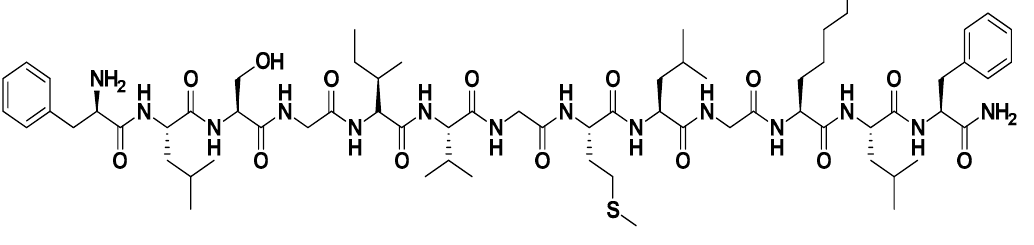
Figure 1. Structure of temporin-SHa. Table 1. Sequence of peptides used in this study. Temporin-SHa (SHa) is the original peptide. Substitution of one Gly or more is shown in red for D -Ala and in blue for L -Ala. NS = no substitution (natural peptide). G4 = Gly at position 4. G7 = Gly at position 7. G10 = Gly at position 10. a = D -Ala. A = L-Ala.